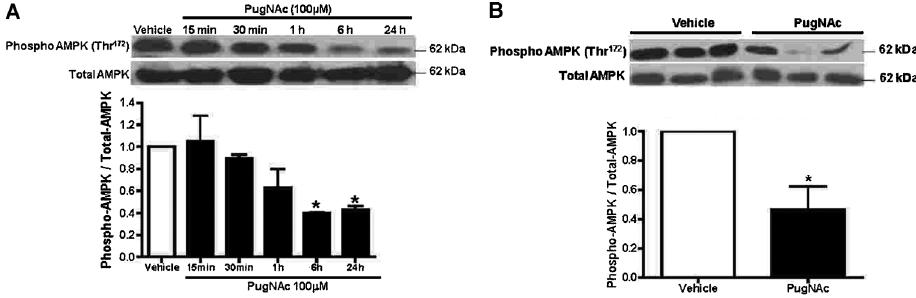
Figure 5. PugNAc incubation produced a time-dependent decrease in phosphorylated levels of AMP-activated protein kinase (AMPK). Vascular smooth muscle cells (VSMCs) cultured from rat thoracic aortas were incubated with PugNAc at different times (15, 30 min, 1, 6 or 24 h). Western blot analysis was performed to evaluate expression of phosphorylated AMPK in comparison to VSMCs that were incubated with vehicle (methanol, for 24 h) ( A ). Thoracic aortas incubated with PugNAc for 24 h also decreased phosphorylation levels of AMPK compared to aortas treated with vehicle (24 h) ( B ). Data are reported as means±SE of the relative expression of the phosphorylated form of AMPK (Thr 172 ) after normalization to the corresponding total protein expression (n=6). *P , 0.05 vs vehicle (10 m L/mL methanol, vehicle to PugNAc) (Student t